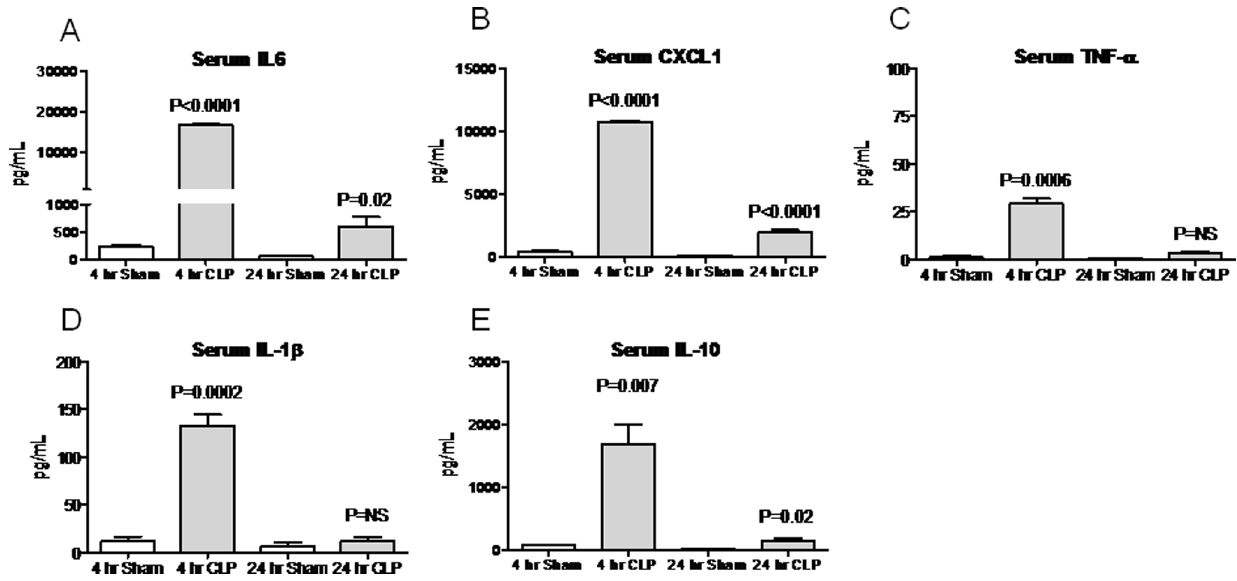
doi:10.1371/journal.pone.0079037.g006